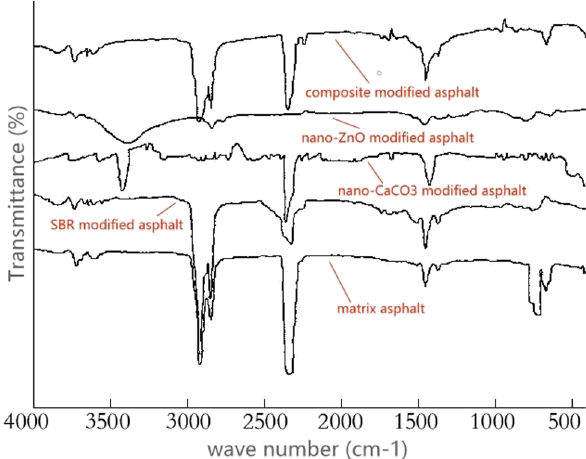
Figure 10: Infrared spectra of fi ve types of